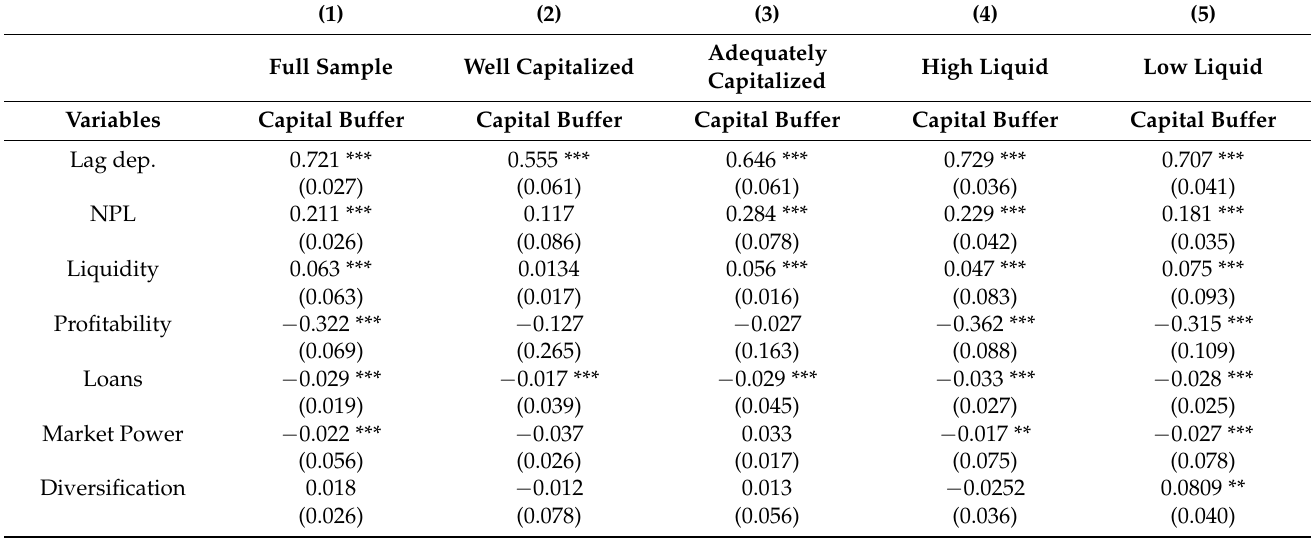
Table 3. Bank capital buffer adjustment under macroeconomic